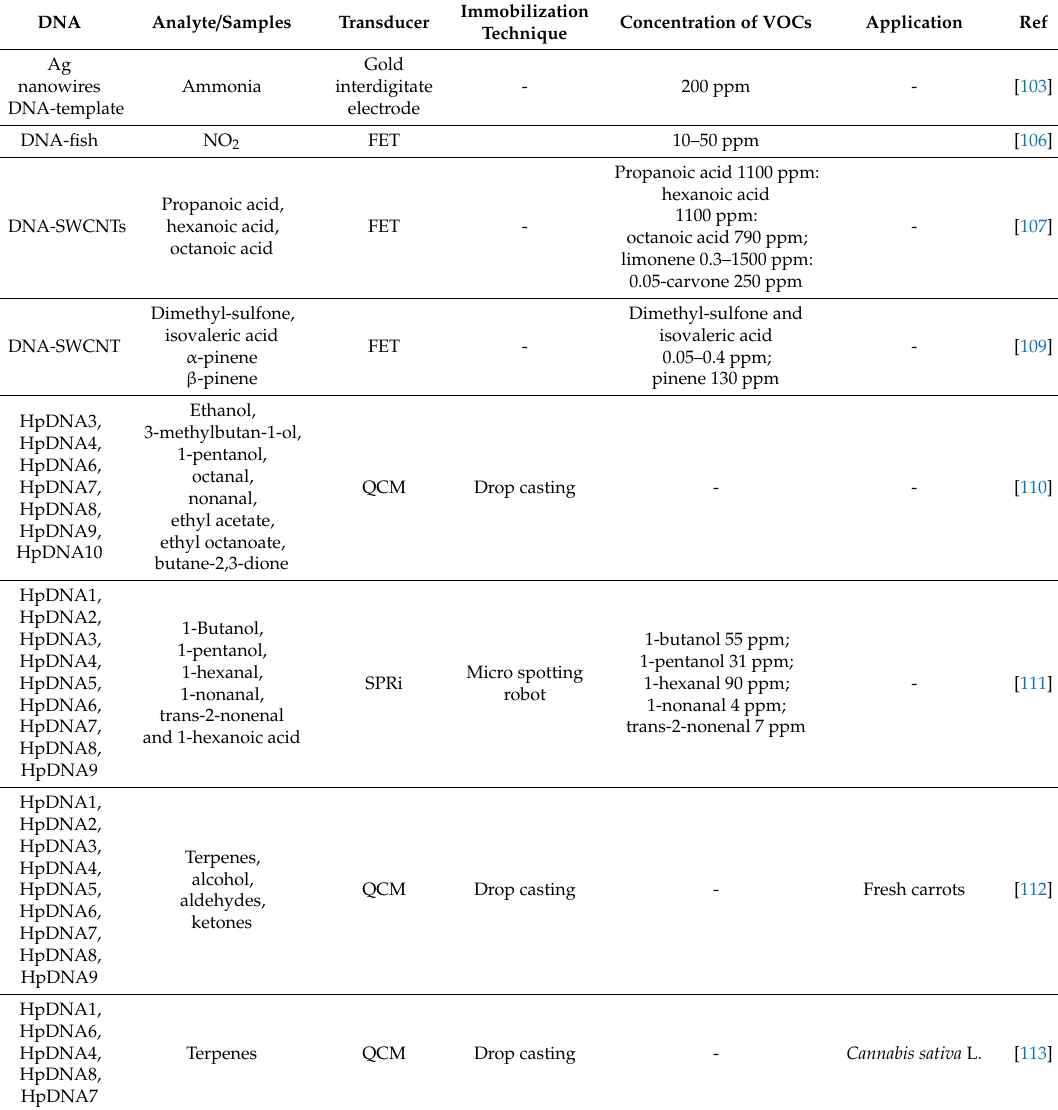
Table 3. Gas sensors equipped with DNA sequences: main features and